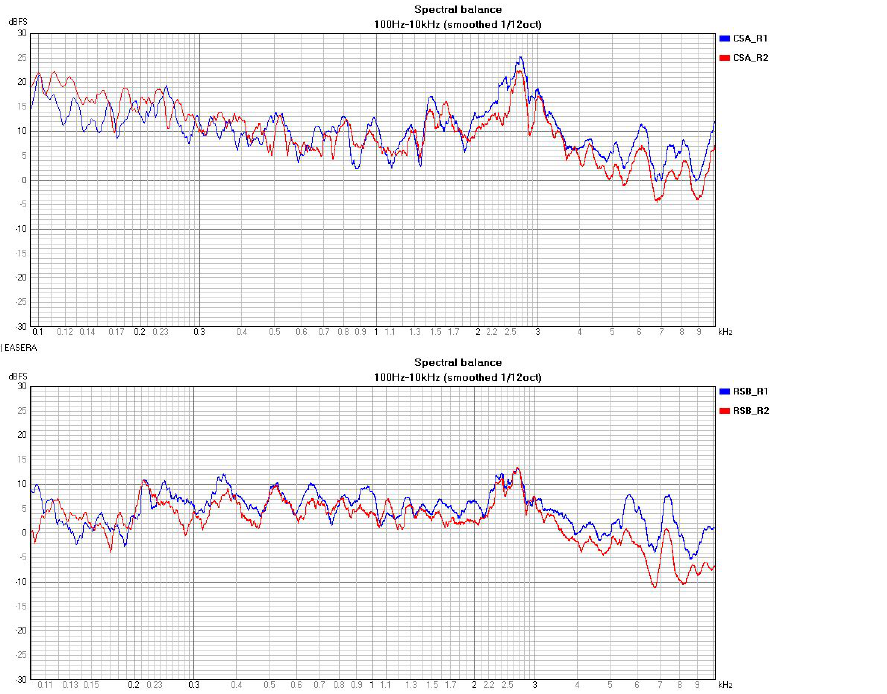
Figure 5. Spectral balance (magnitude response, on a logarithmic frequency scale) from impulse response measurements in CSA ( above ), and RSB ( below ). The R2 positions (red) in both historical case-study sites show decreased high-frequency energy above 3 kHz as compared to R1 (blue), as expected due to air